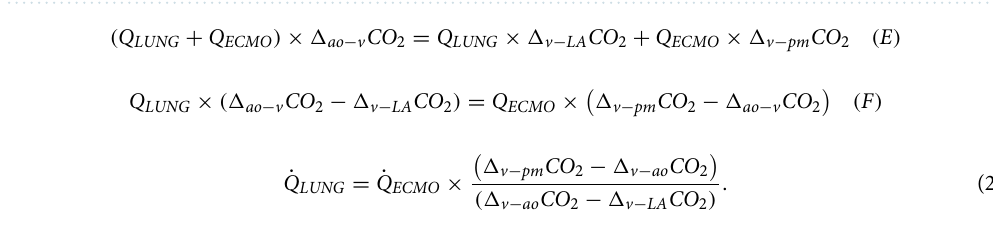
Figure 2. Step 1a and 1b. Experimental Manoeuvres (Step 1a, 1b, 2a, 2b). In the first part, weaning of ECMO blood flow was conducted with reductions of 500 ml and corresponding equal ̇ increases of lung blood flow, . . V / ˙ Q was evaluated at a constant and varying V / ˙ Q summing up to a systemic blood flow of 2500 ml. The effect of ratio (Step a and b, respectively). Both manoeuvres were triplicated at 0%, 20% and 40% pulmonary shunt. Step 2a and 2b. A second part investigated the effects of limiting venous return (Step a) or limited pump function (step b). Venous return was limited by incomplete transfer of the weaned ECMO blood flow to lung blood flow (25% and 50% reduction), leading to venous pooling of blood. Limited cardiac function was simulated by a constant RPM at the lung